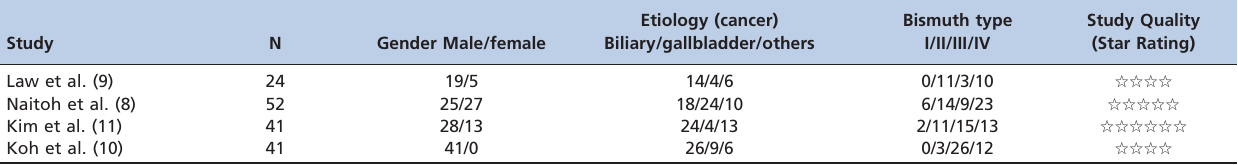
Table 1 - Characteristics of the included studies.